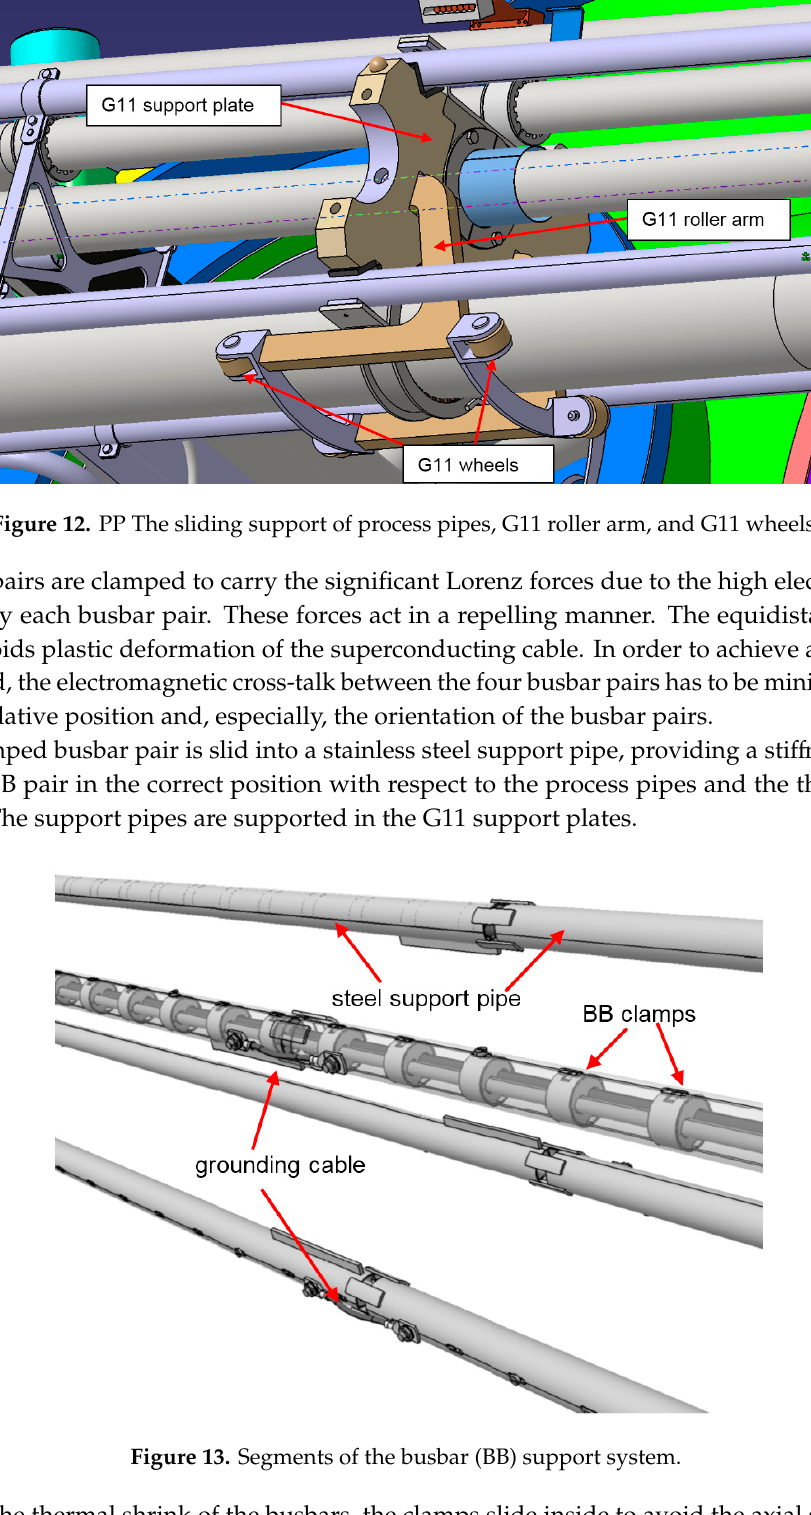
Figure 14. Thermal compensation loops on the busbar pairs on the support plates. 4. Delivery and Tests Results The first module of the SIS100 cryogenic bypass line (Figure 15) was delivered by Wroclaw University of Science and Technology to GSI in the middle of 2016. This module is being used as part of the SIS100 String Test Facility (STF) to verify the operation of a short chain of SIS100 superconducting magnets. The first series module connects the STF feed box to the tested short chain of magnets.